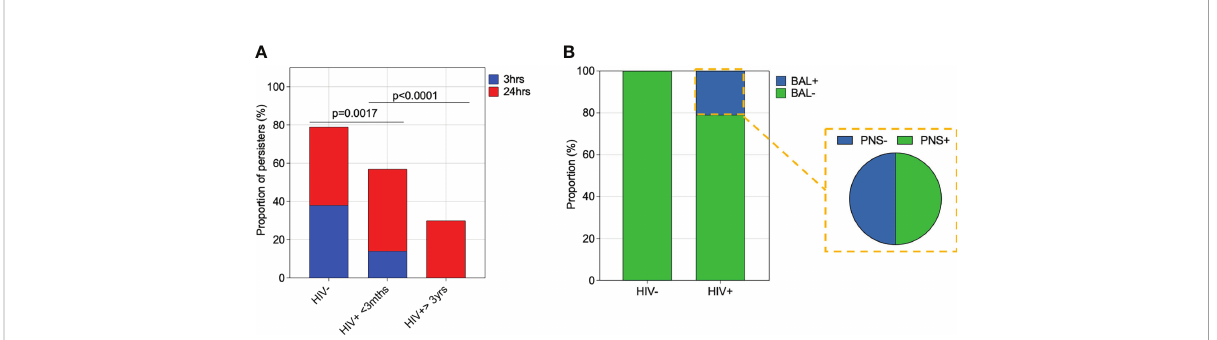
FIGURE 6 Impact of HIV infection on pneumococcal intracellular survival in alveolar macrophages. (A) Alveolar macrophages (AMs) were co-incubated with IgG-opsonised viable ST3 at MOI 50 for 1 hour, gentamicin was added for 30minutes, then the cell culture supernatant was removed, replaced with gentamicin-free cell culture media and cells incubated. Proportion of individuals with viable ST3 at 3 and 24 hours following lysis of AMs. HIV-uninfected (n=29), HIV-infected on ART <3 months (n=21), HIV-infected ART>3 years (n=10). Statistics were calculated using Chi- squared test. (B) AMs not exposed to experimental ST3 were cultured for 24 hours and subsequently lysed for the detection of viable intracellular pneumococci by microbiological culture. A higher proportion of Individuals with treated HIV had pneumococci in their AMs compared to the HIV-uninfected individuals (HIV+ n=31, HIV- n=18). Fifty percent (n=6) of the individuals with viable pneumococci in AMs also had viable bacteria on their nasal